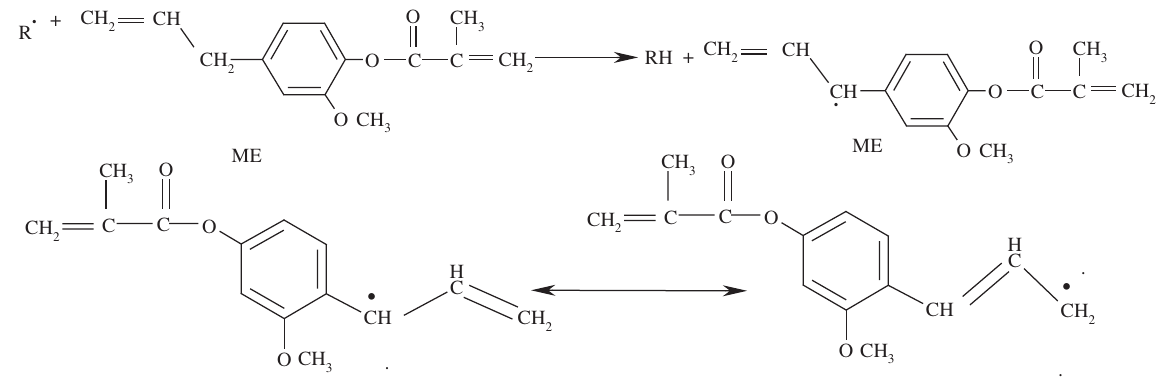
Figure 7: The resonance stabilization of the allylic free radical in ME molecule taken for